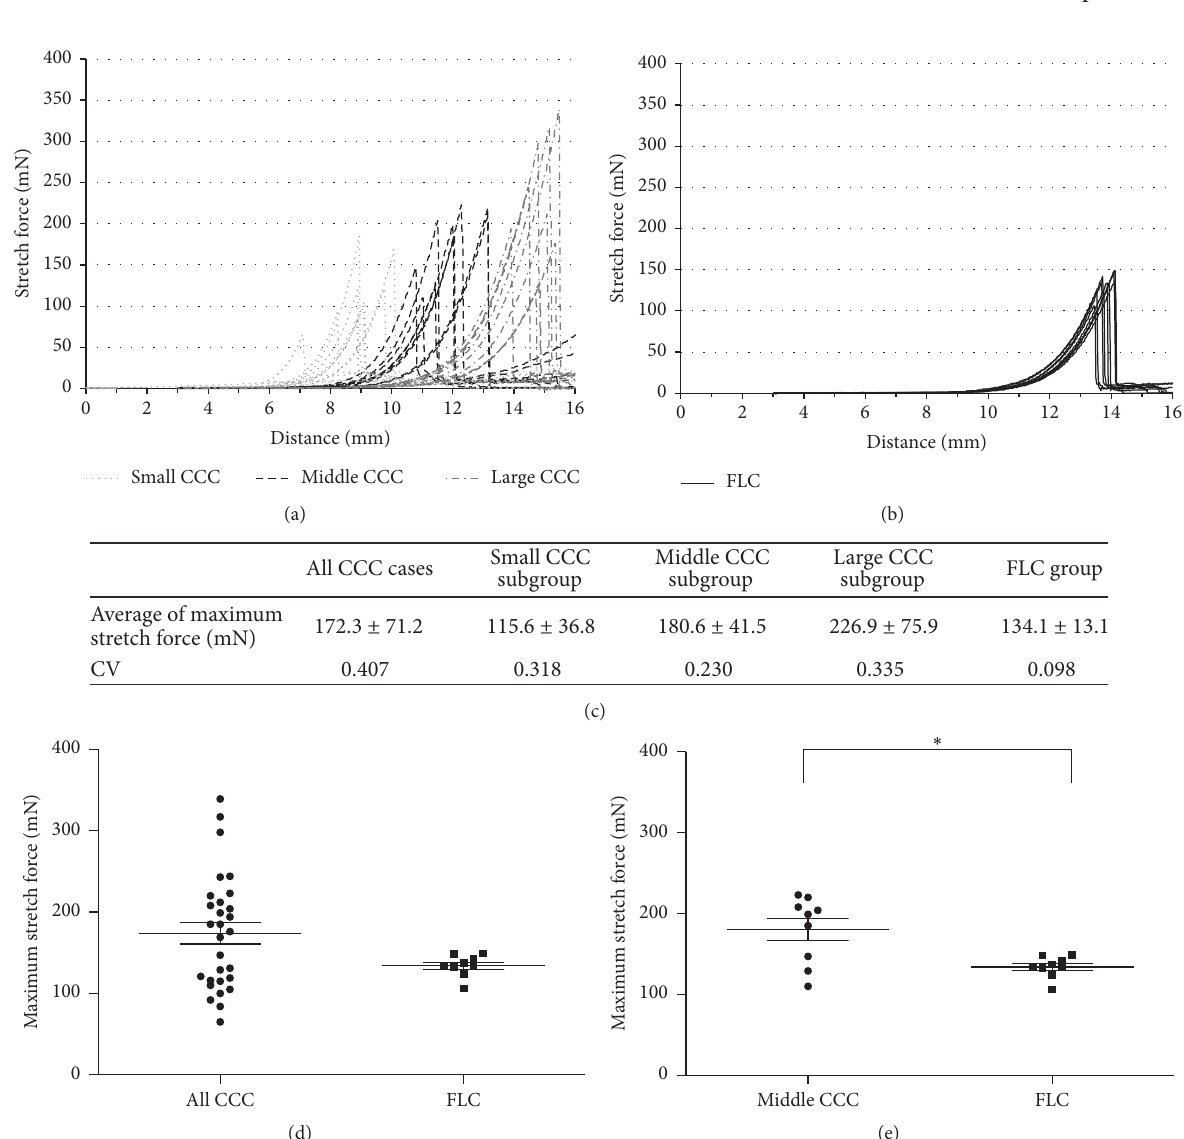
stretch force between the CCC group ( 172.28 ± 71.2